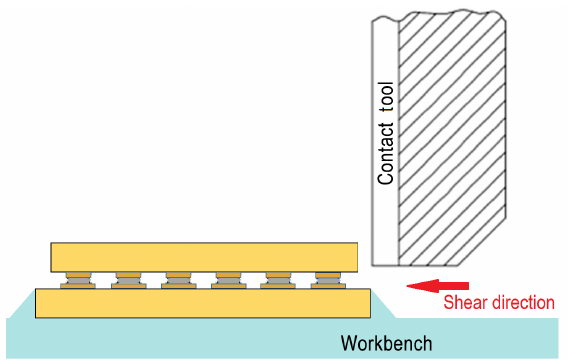
Figure 8. Shear test setup for the characterisation of mechanical stability of the conductive adhesive